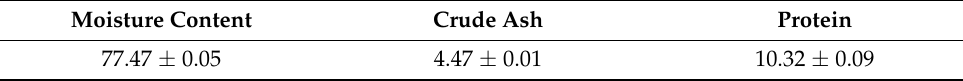
Table 2. The concentrations of proximate composition in SH (wet basis,